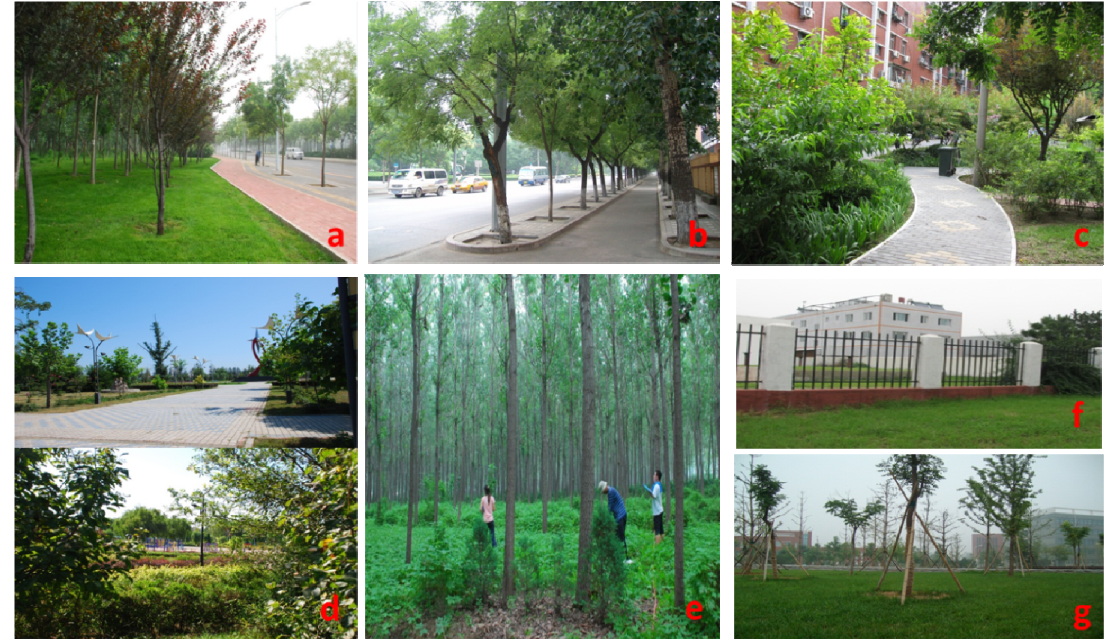
Figure 2. The seven types of land use in our study: ( a ) Road greenbelts; ( b ) Roadside; ( c ) ( g ) Institutional sites.